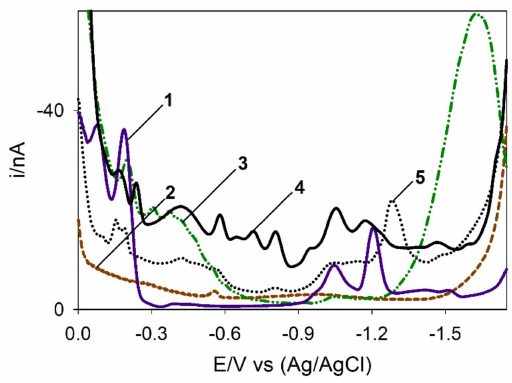
Figure 3. SW voltammograms of (1) PC c = 10 − 7 mol dm − 3 , (2) PG c = 10 − 7 mol dm − 3 , (3) PE c = 10 − 7 mol dm − 3 , (4) mixture of natural lipids, and (5) phospholipids after extraction; E acc = 0 V, t acc =180 s, E step = 2 mV, a = 20 mV, f = 60 s − 1 , v = 50 mV s − 1 ; 0.55 mol dm − 3 NaCl, pH = 8.2. Interaction of Co(II) with 1,10-Phenantroline and Standard